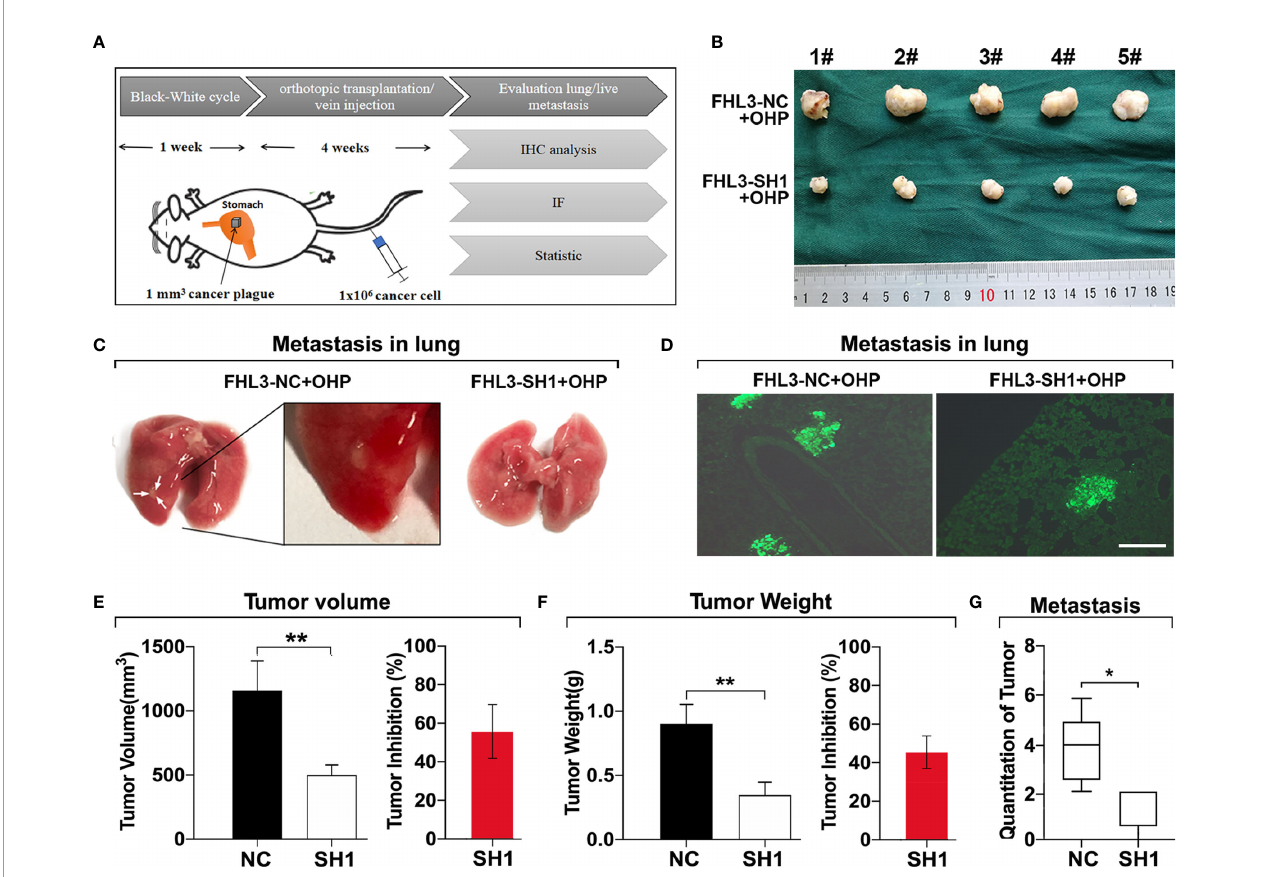
FIGURE 6 | FHL3 knockdown decreased tumor metastasis in orthotopic transplantation model and lung metastasis model. (1) The schematic diagram of orthotopic transplantation model and lung metastasis model (A) ; (2) Display of tumors harvested from orthotopic stomach after tumor transplantation and OHP treatment in SCID mice (B, E , F) ; (3) Metastatic tumors in lungs were displayed in original lung specimens and the fl uorescence (200× magni fi cation) of frozen slices were detected (C, D, G) ; those results indicated FHL3 knockdown can decrease the lung